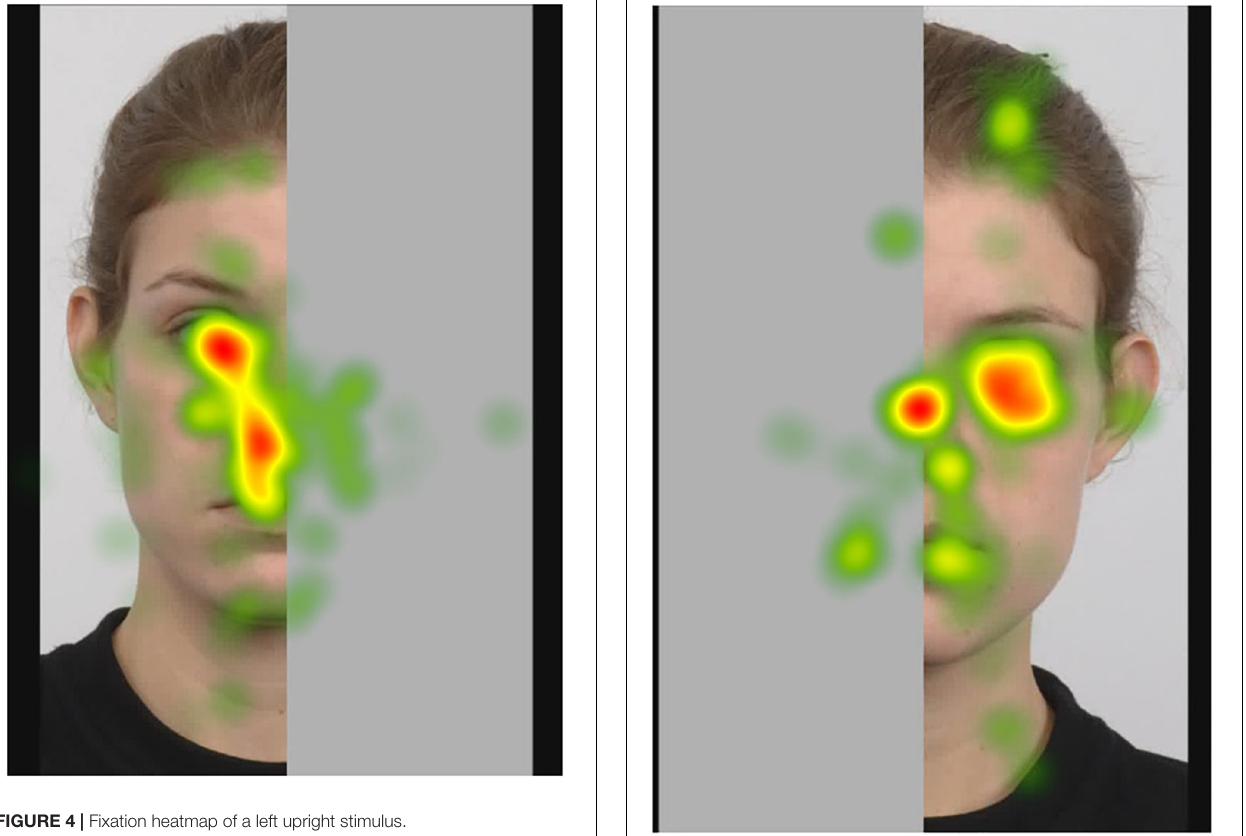
FIGURE 4 | Fixation heatmap of a left upright stimulus.